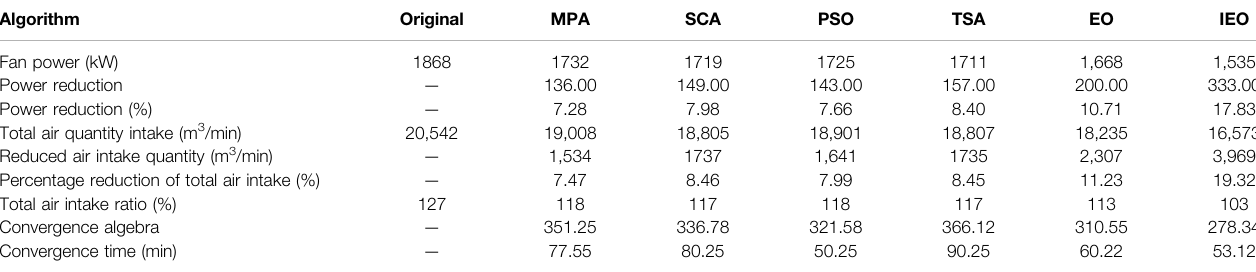
TABLE 5 | Comparison of the average results of 50 optimizations. Algorithm